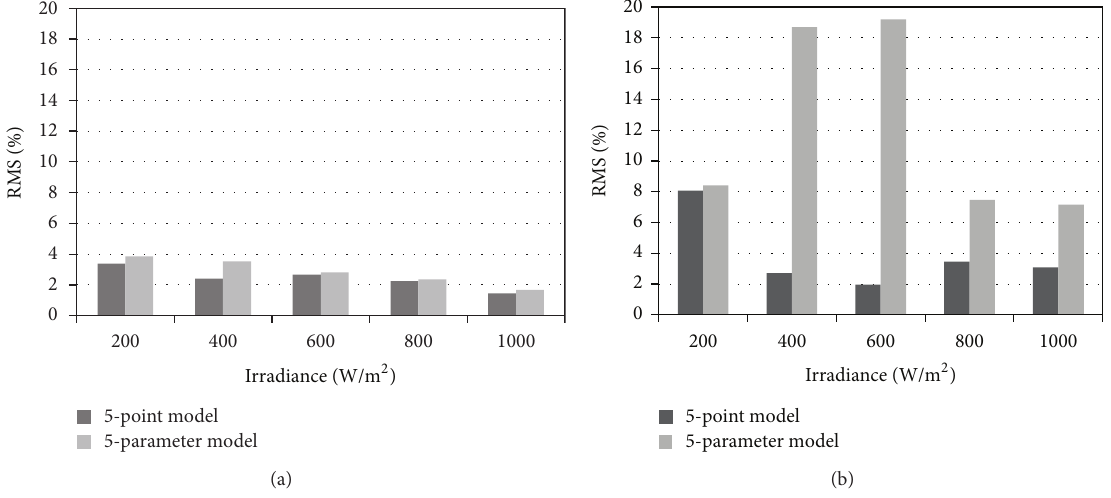
Figure 4: %RMS for Shell SP75 (a) and GES-P70 (b) at different irradiations, 25 ∘ C.